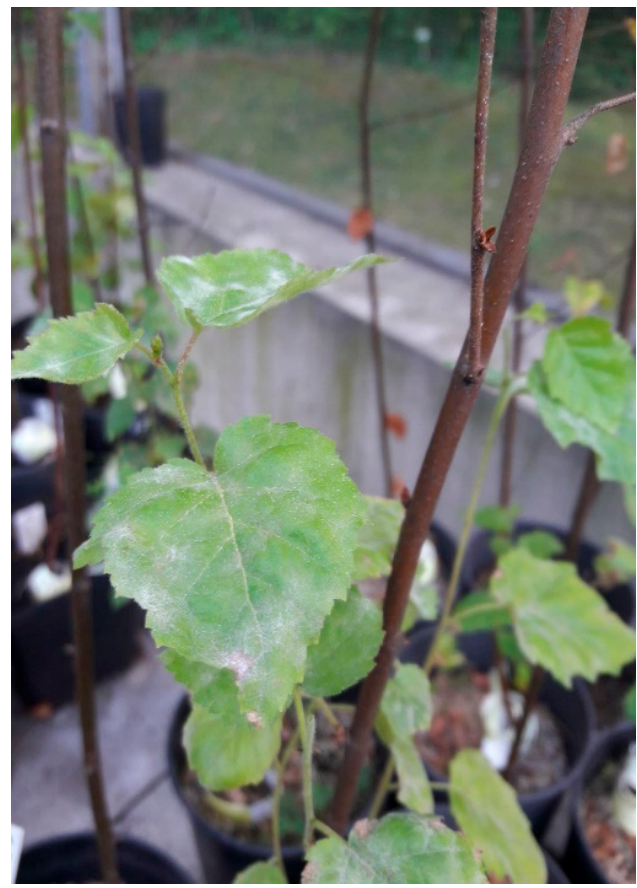
Figure 6. Mildew on birch leaves.